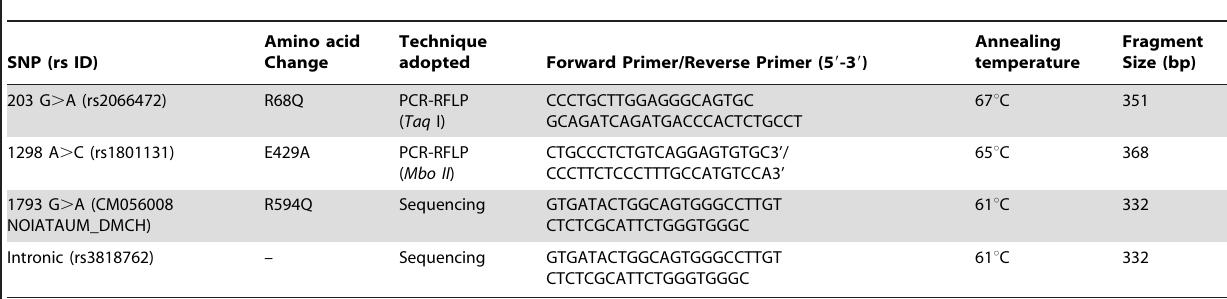
Table 1. List of the SNPs analyzed along with PCR primers and techniques used for genotyping.